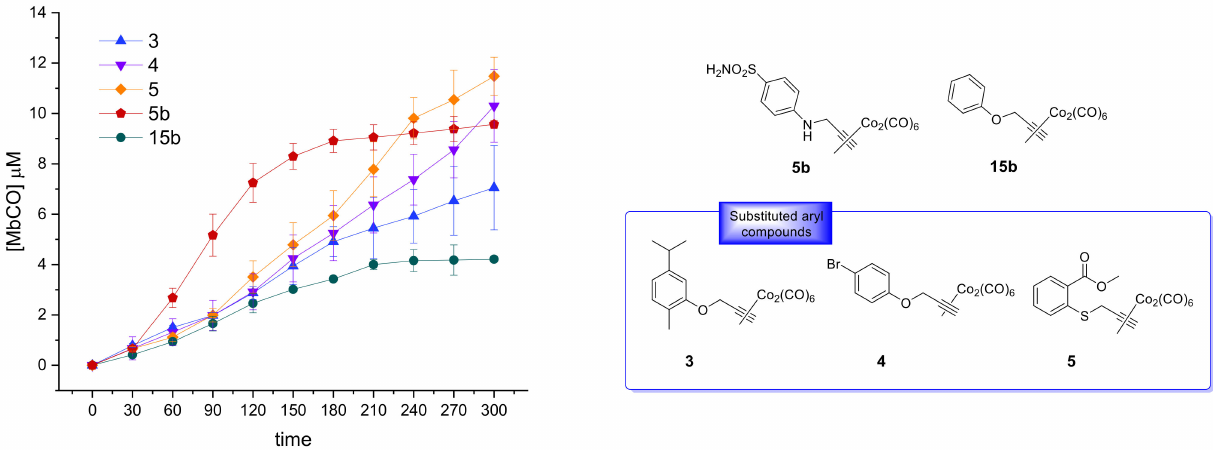
Figure 4. CO release profiles for the aryl substituted DCH/CO-RMs 3 – 5 and the reference compounds 5b and 15b (left), along with their chemical structures (right).